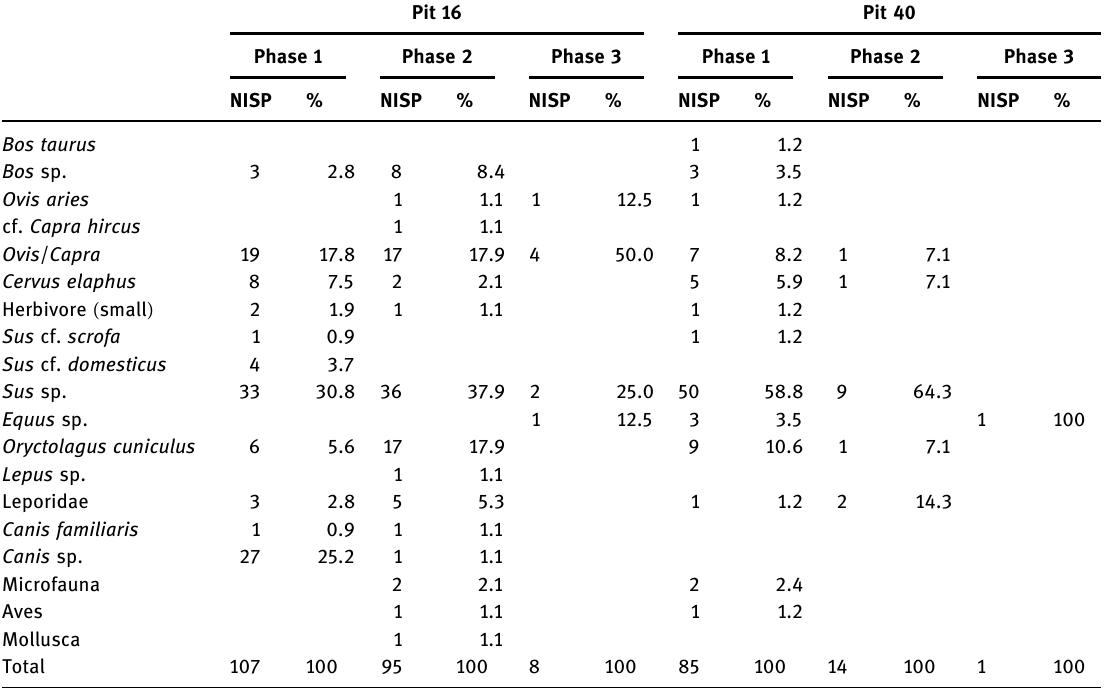
Table 3: Dispersion of number of identi fi ed specimens ( NISP ) per di ff erent phases of pits 16 and 40 Pit 16 Pit 40 Phase 1 Phase 2 Phase 3